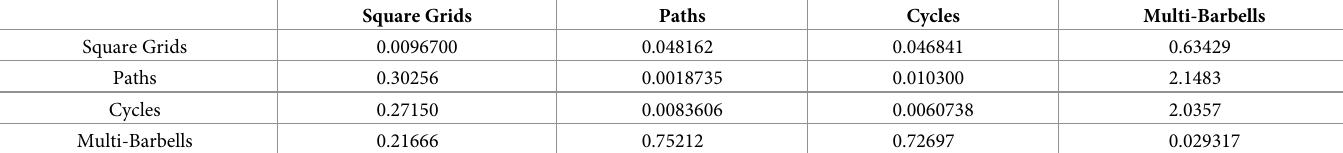
Table 2. Mean distances between graphs in several lineages. For two lineages G 1 , G 2 ... (listed at left) and H ! , H 2 , ... (listed at the top), each entry shows the mean dis- tance D ( G i , H i +1 ) (where the average is taken over i = 1 to 12). As expected, we see that the distance from elements of a graph lineage to other members of the same lineage (the diagonal entries of the table) is smaller than distances taken between lineages. Furthermore as expected, 1D paths are more similar (but not equal) to 1D cycles than to other graph